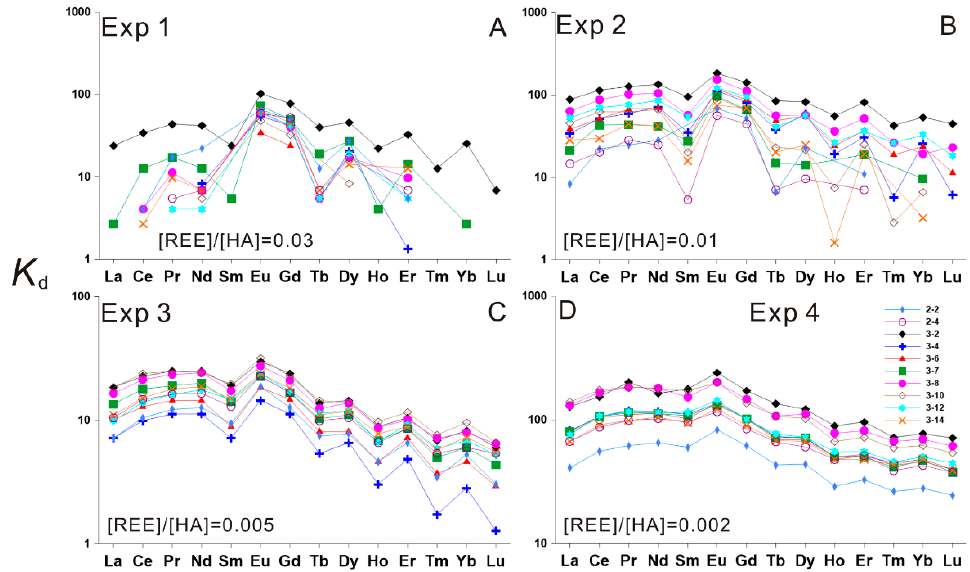
Figure 4. REE distribution pattern of K d obtained at 100 °C and various [REE]/[HA] ratios. ( A ), Experiment 1, performed at a [REE]/[HA] concentration ratio of 0.03 ([REE]/[HA] = 0.03); ( B ), Experiment 2, performed at [REE]/[HA] = 0.01; ( C ), Experiment 3, performed at [REE]/[HA] = 0.005; ( D ), Experiment 4, performed at [REE]/[HA] = 0.002 .